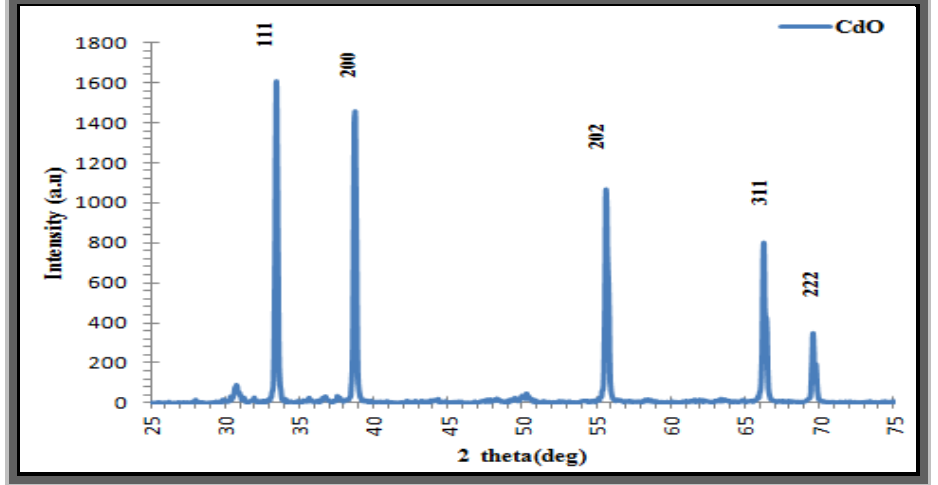
Fig. 3: Patterns of XRD for CdO powder.